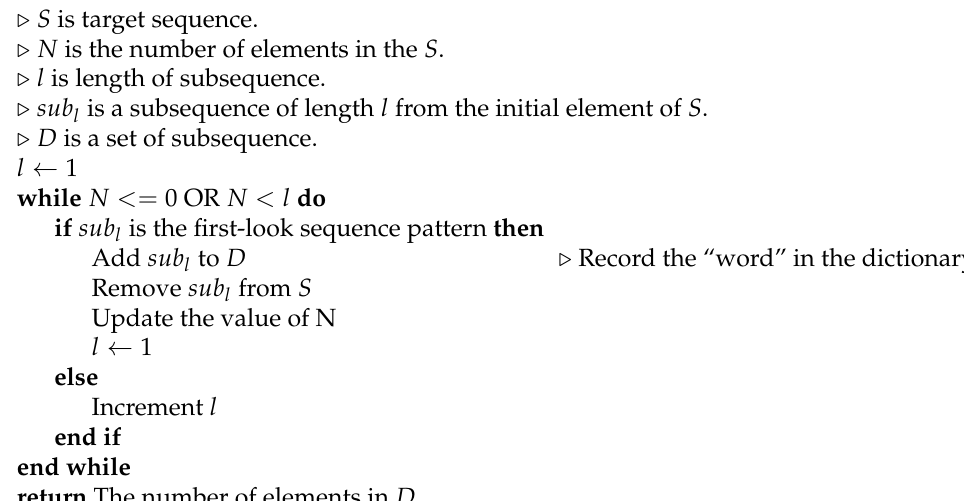
Algorithm A1 pseudocode to calculate Lempel–Ziv